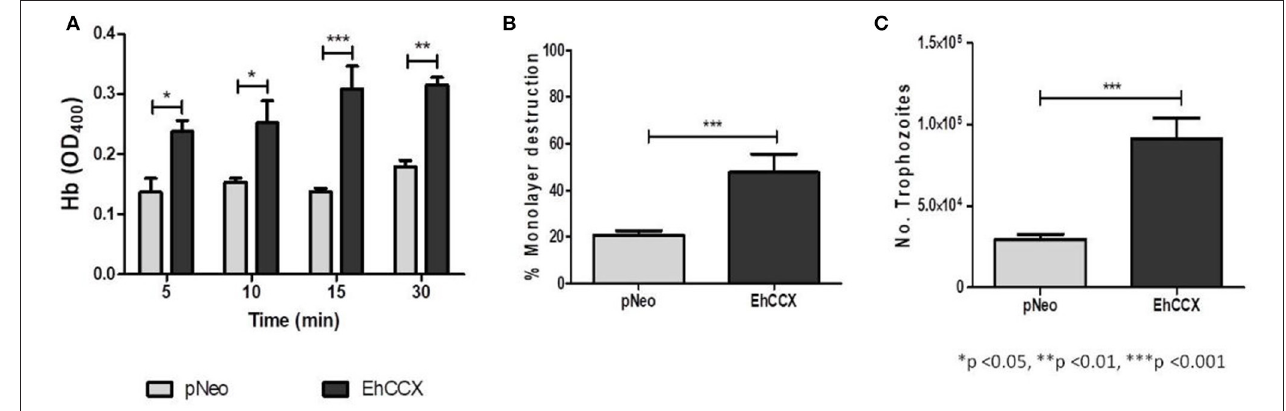
FIGURE 11 | Effect of the EhCCX overexpression on the in vitro virulence. (A) pNeo and pNeo/EhCCX trophozoites were incubated with human erythrocytes at 37 ◦ C during 5, 10, 15, and 30min. Then, non-ingested erythrocytes were lysed by incubation by 10min with distilled water. After several washes with PBS, trophozoites were lysed with formic acid; and the hemoglobin released from the erythrocytes ingested was determined by absorbance at 405nm. (B) MDCK cell monolayers were incubated with pNeo or pNeo/EhCCX trophozoites during 2h at 37 ◦ C, and the monolayer destruction was evaluated as described in Material and Methods. (C) Serum-starved trophozoites were placed in the upper chamber of transwell inserts and 500 µ l of adult bovine serum was added to the lower chamber. Then, trophozoites were incubated for 3h at 37 ◦ C and migration was determined by counting the number of trophozoites at the lower chamber of the well. Data are expressed as the mean ± standard error of three independent experiments performed by